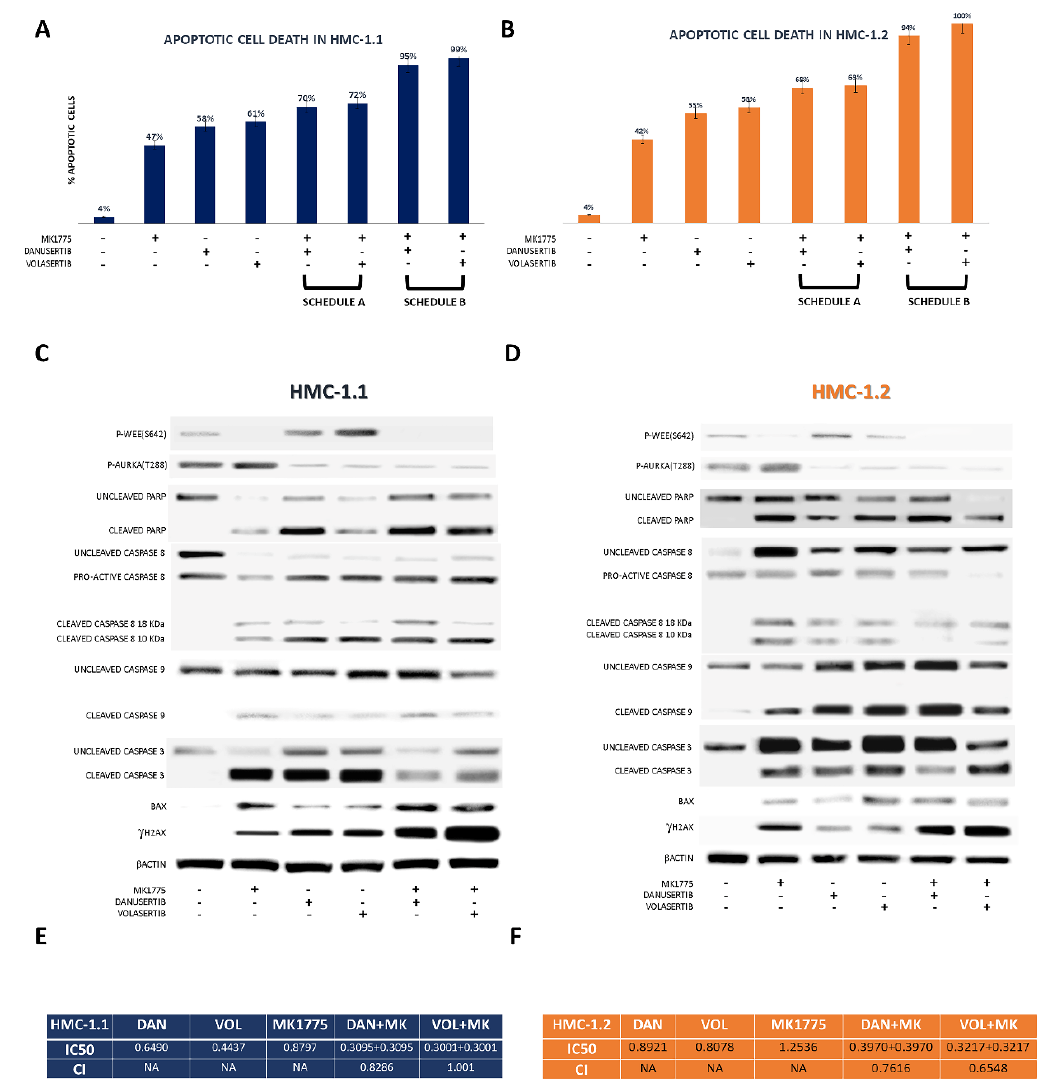
Figure 3. Effects of AKA or Plk1 inhibition in association with WEE1 inhibition. Flow cytometry analysis of apoptosis induction in HMC-1.1 ( A ), and HMC-1.2 ( B ) cells, following 48 h treatment with danusertib or volasertib alone or in combination with MK1775 (schedule A, 48 h with both drugs), or 24 h-treatment with danusertib or volasertib followed by 24 h-treatment with danusertib or volasertib + MK1775 (schedule B). Western blot analysis of apoptosis-related proteins in HMC-1.1 ( C ) and HMC-1.2 ( D ) cells following treatment with AKA, Plk1 or WEE1 inhibitors as single agents or in combination according to schedule B. Beta-actin was used as a loading control. ( E , F ) Results obtained by cell death data analysis performed by using Compusyn software and CI